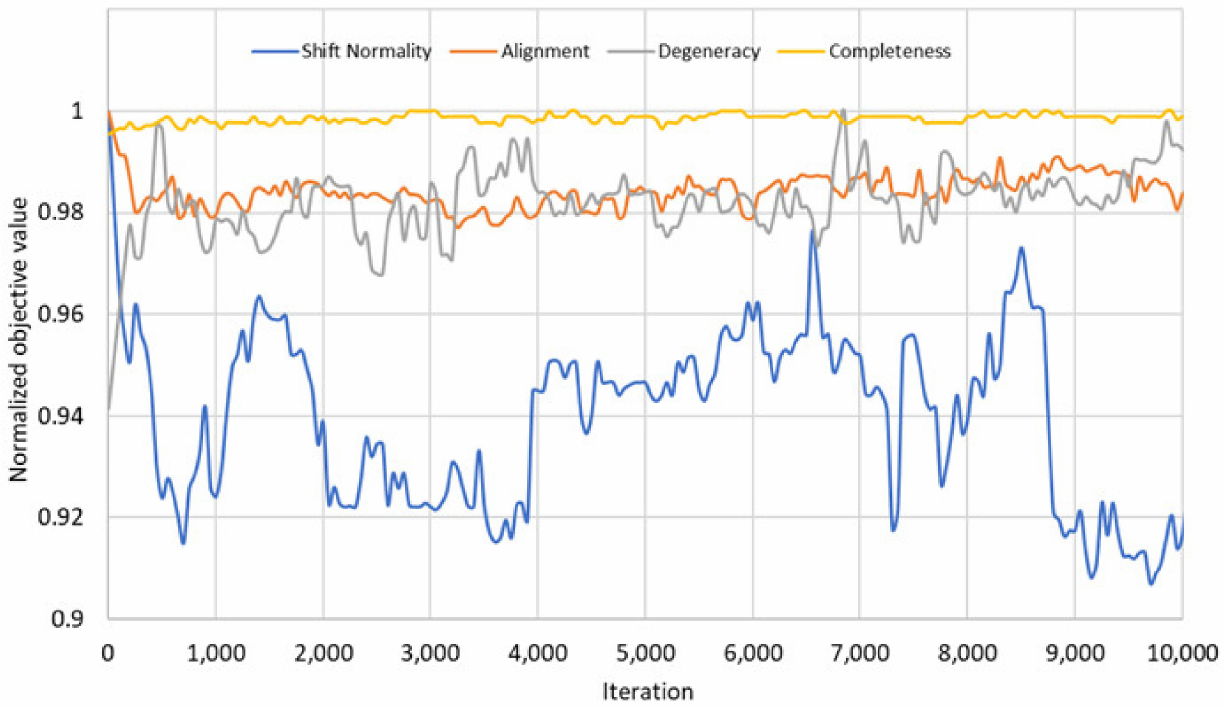
Figure 6. Values of the four different objectives, shift normality (blue), alignment (orange), degeneracy (grey), completeness (yellow), during optimization for the 4th fragment of Fes SH2. Values of each objective are scaled to a maximal value of